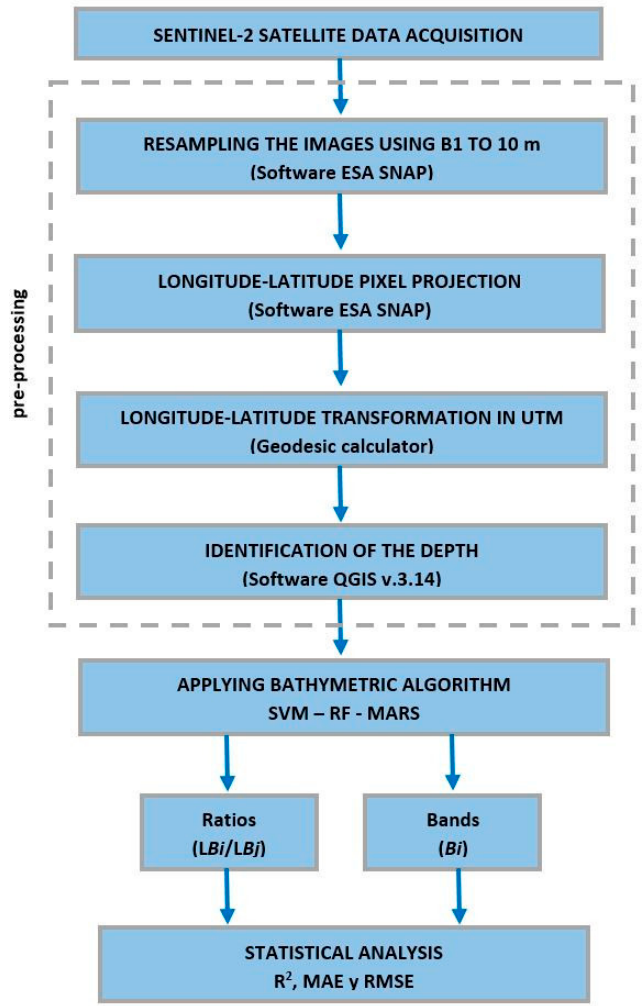
Figure 3. Methodological workflow for obtaining bathymetric maps from Sentinel-2 images.